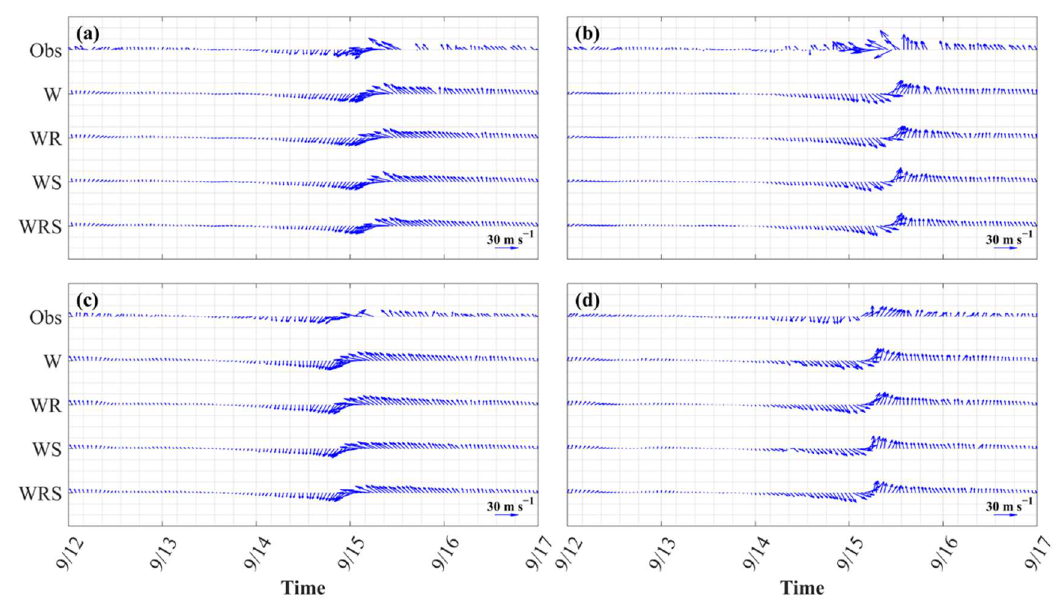
Figure 8. Comparison of observed and simulated wind direction (vectors) at ( a ) Buoy 1; ( b ) Buoy 2; ( c ) Buoy 4; and ( d ) Buoy 5.